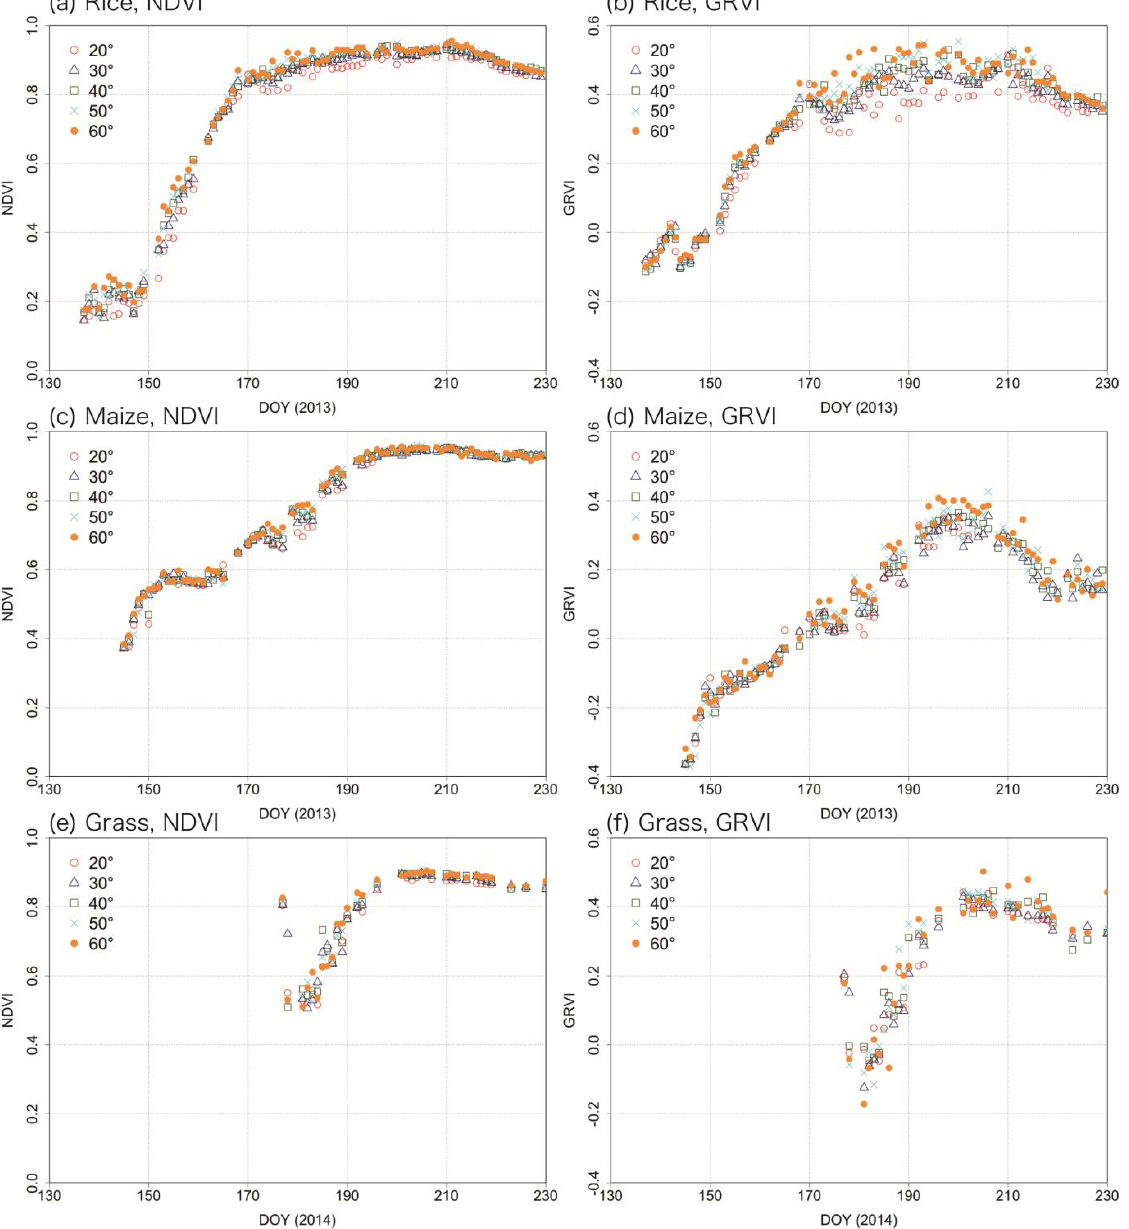
Figure 1. Time series of the NDVI ( left ) and the GRVI ( right ) with the same solar zenith angles (20  , 30  , 40  , 50  , and 60  ) during the growing season at the rice ( a , b ), maize ( c , d ), and grass ( e , f )